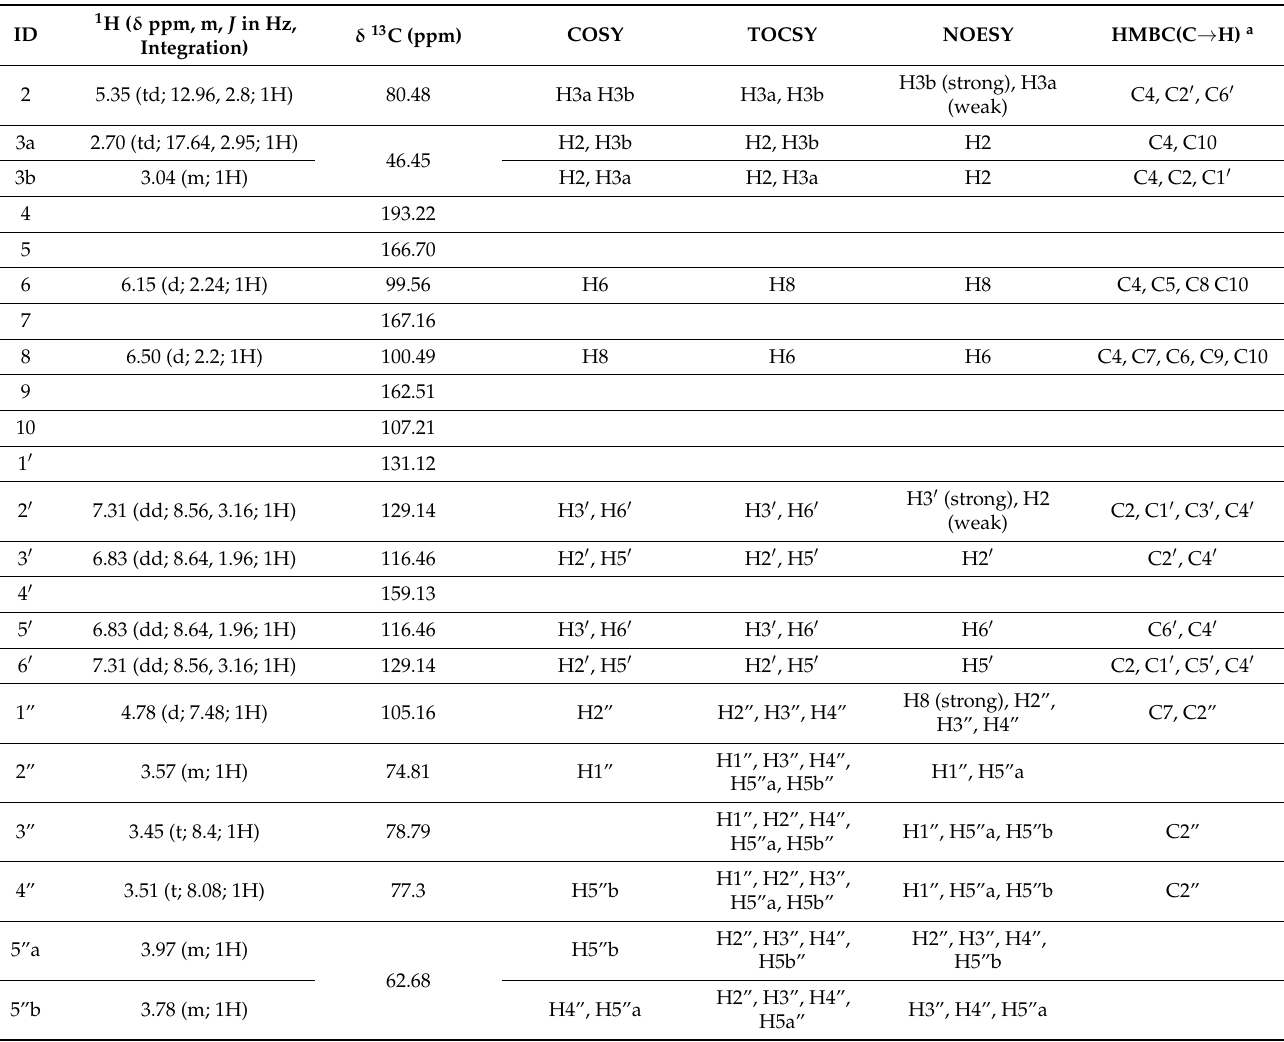
Table 4. The 1- and 2-D NMR data of naringenin-7-O- α - L -arabinopyranoside 2 (FL-MeOH-A3 in CD 3